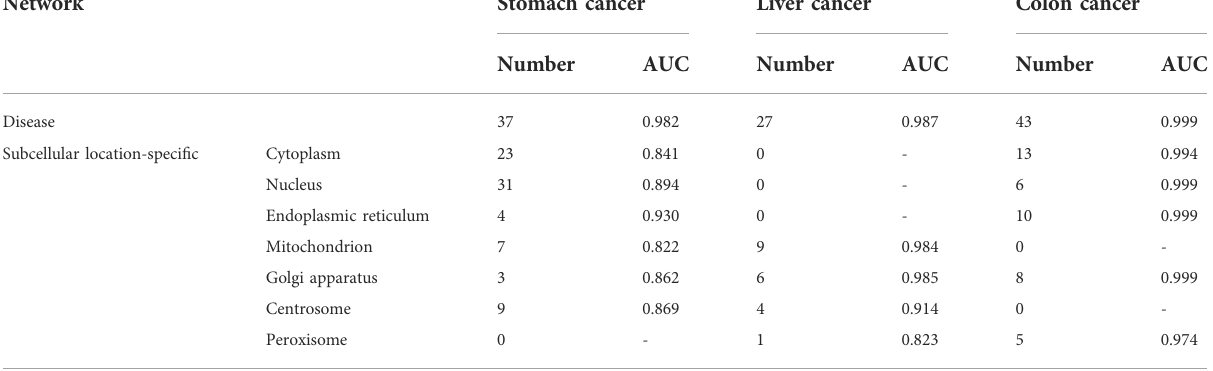
TABLE 5 Leader genes for stomach, liver, and colon